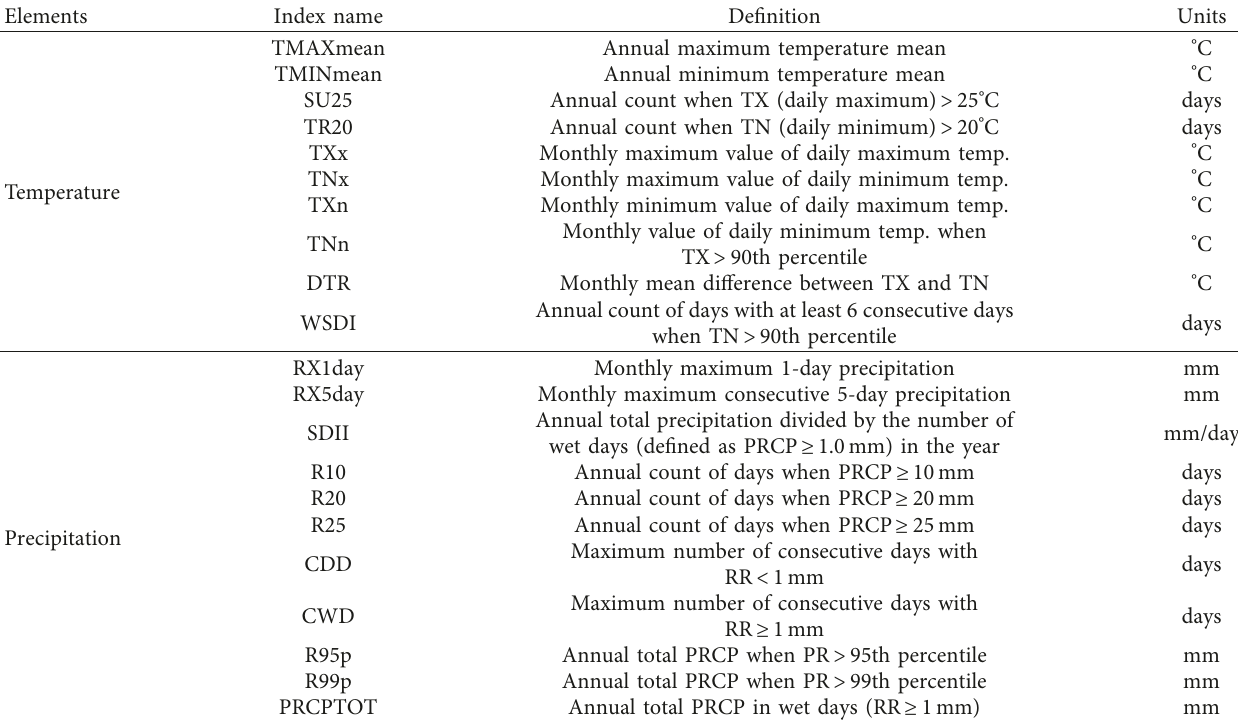
Table 1: List of the ETCCDI extremes investigated in this study.